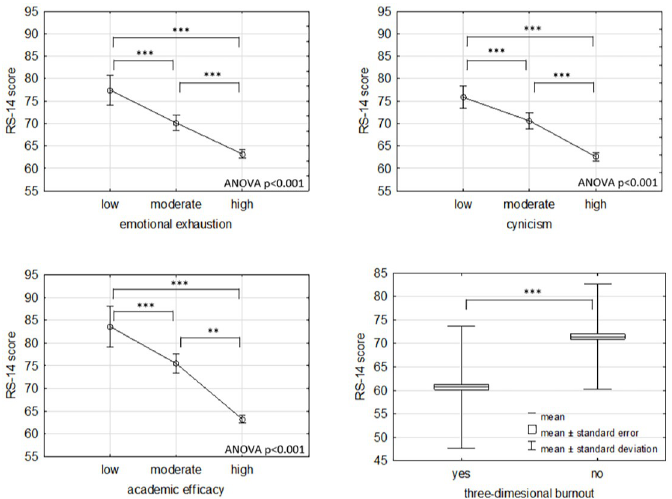
Fig 4. Mean RS-14 scores for participants presenting burnout in particular dimensions at low, moderate and high levels (ANOVA) and mean RS-14 scores for participant demonstrated three-dimensional burnout’. �� p < 0.01; ��� p < 0.001.